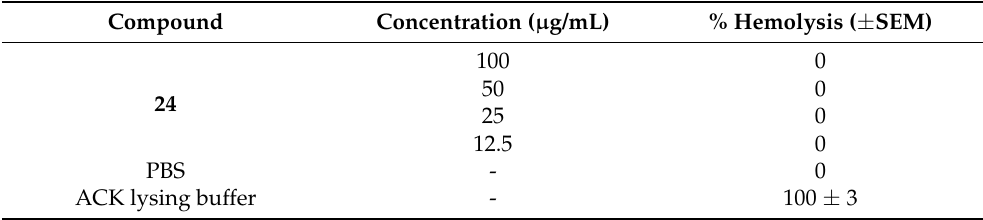
Table 3. Hemolytic assay using different concentrations of mannosylated liposomes assembled from 24. Red blood cells were isolated from three healthy volunteers and ran in triplicate with various concentrations of 24 . PBS was used as a negative control (0% hemolysis) and ACK lysing buffer was used as a positive control (100% hemolysis). All tested concentrations of 24 had 0% of hemolysis. Compound